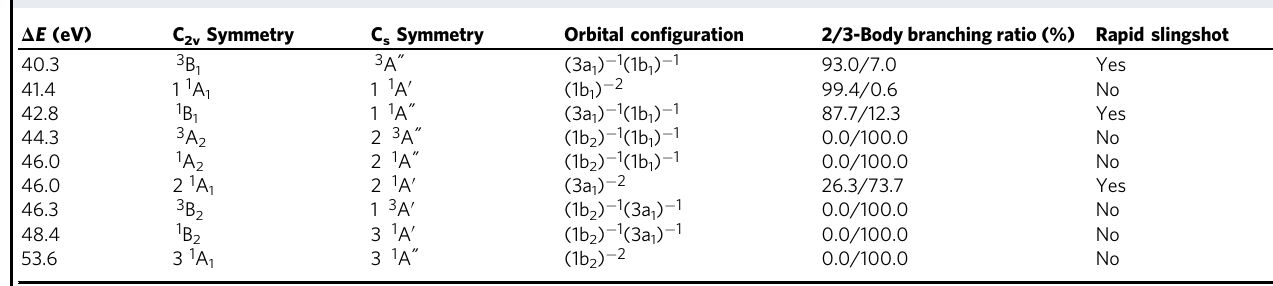
Table 1 Electronic states of D 2 O 2 +